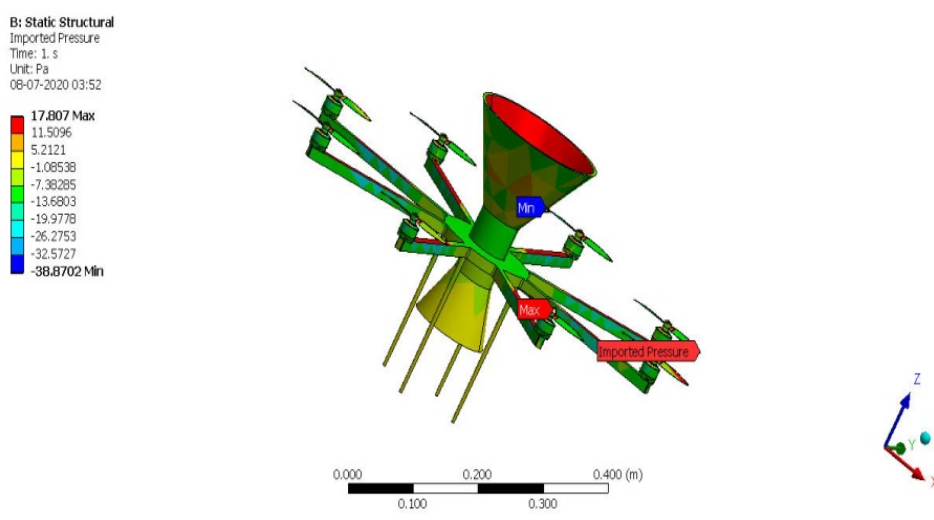
Figure 29. Import load from aerodynamic pressure.